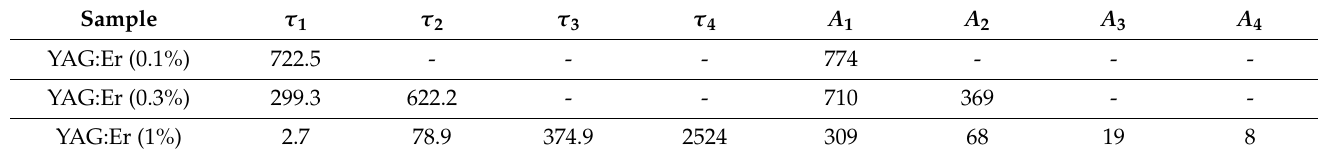
Table 4. Decay time constants (ns) and amplitudes (arb.